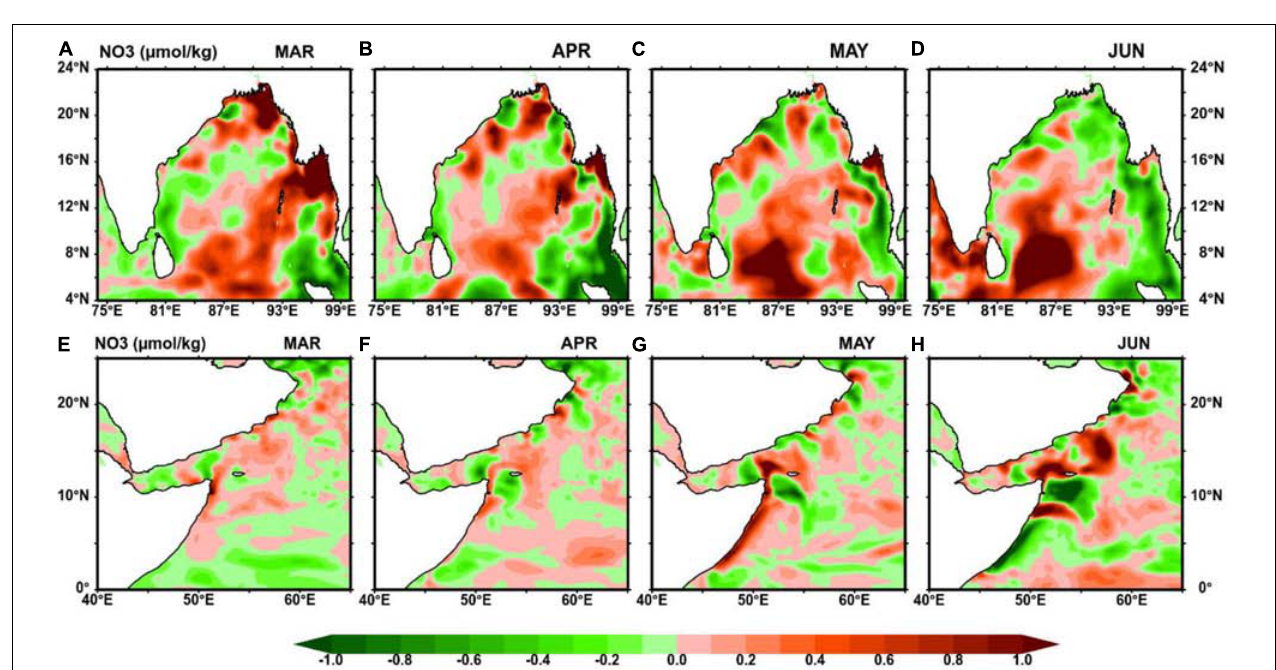
FIGURE 10 | Difference (pandemic – pre-pandemic) in model-simulated Nitrate (NO 3 ) concentration (micromol per kilogram) averaged from surface to 75 m depth over the BoB (A–D) and WAS (E–H) .